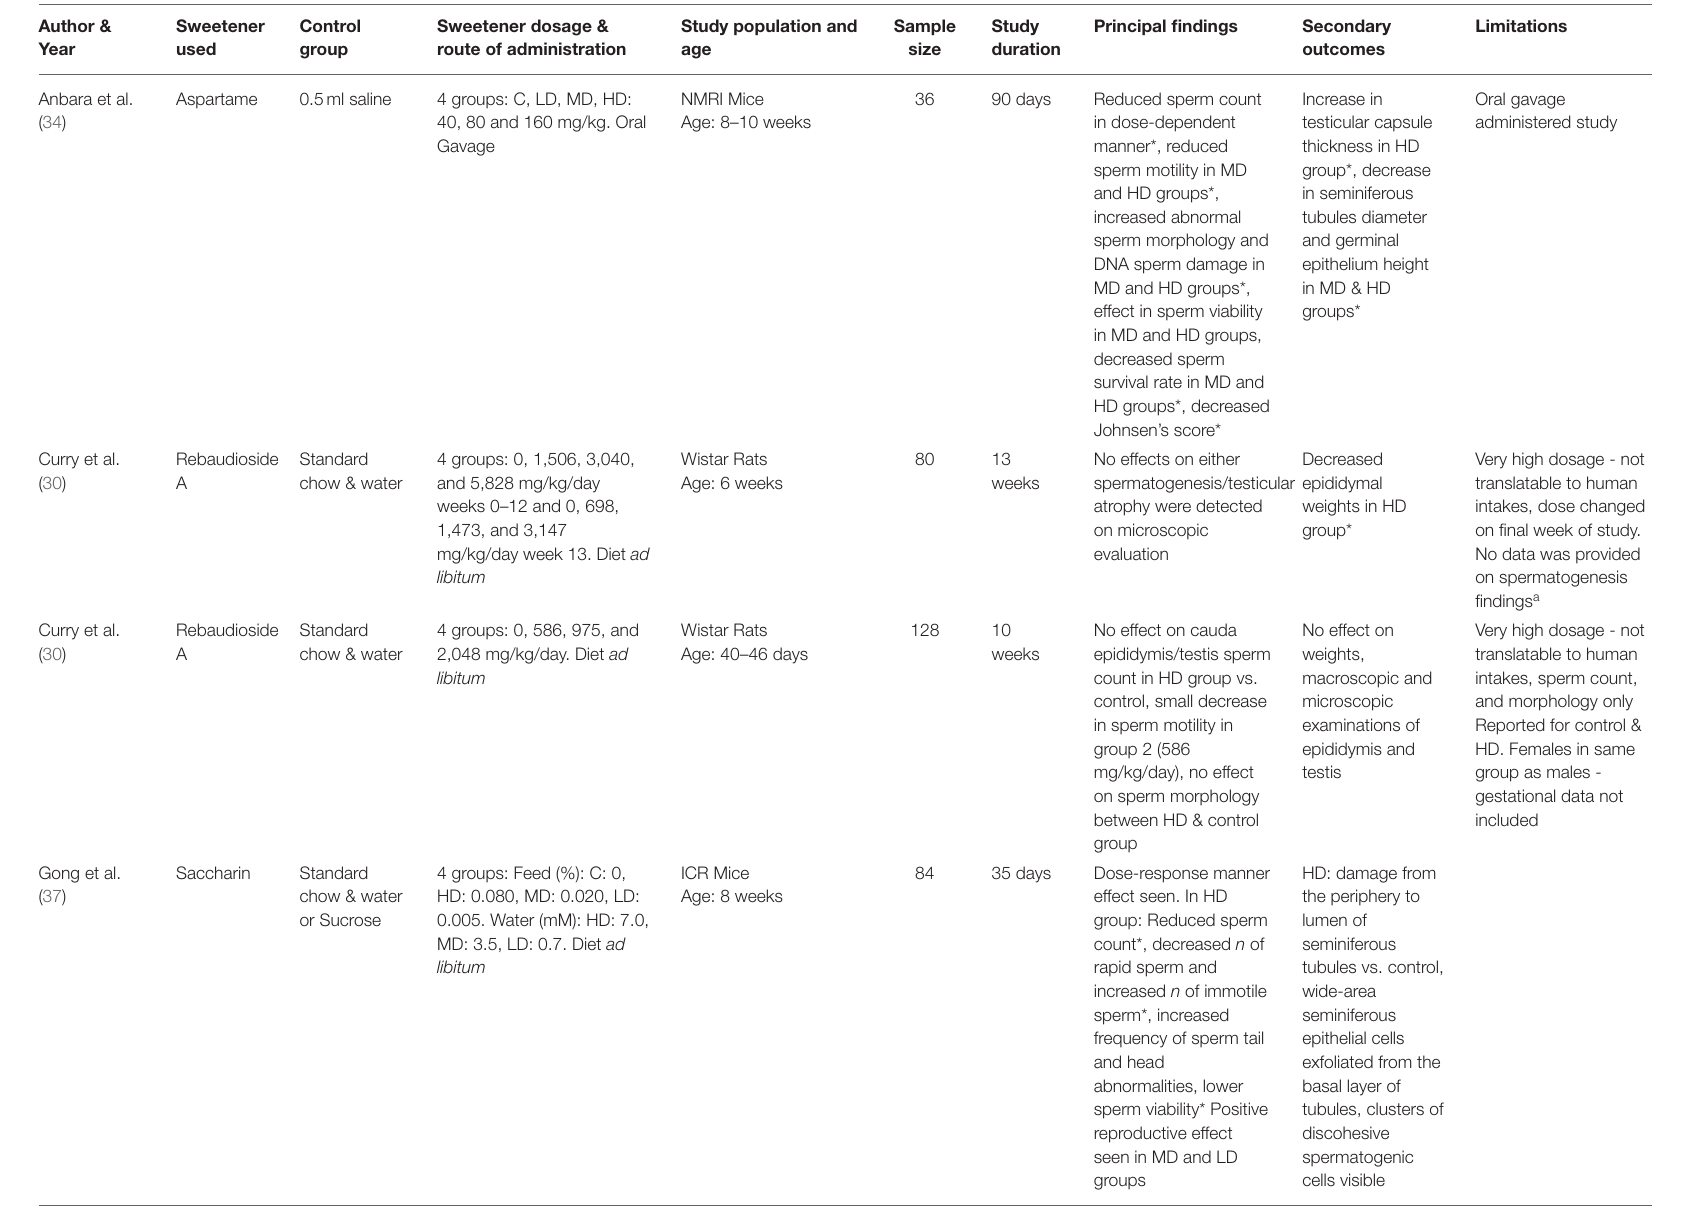
TABLE 2 | Main characteristics and findings of the included